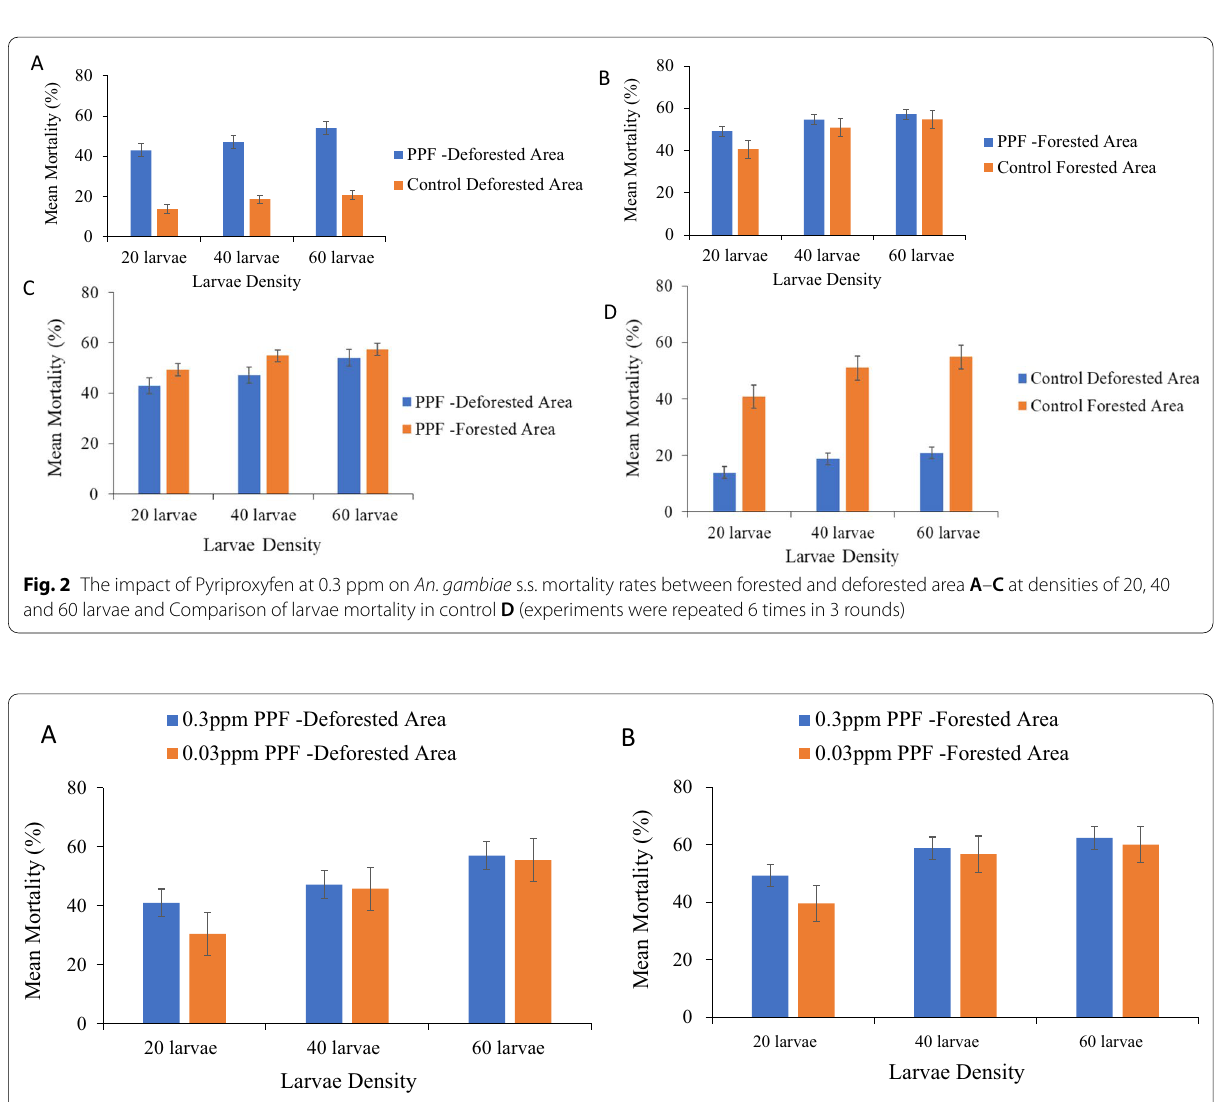
Fig. 3 Effect of changing PPF concentration from 0.03 to 0.3 ppm ( A and B ) on An. gambiae larvae mortality rates at 20, 40 and 60 larvae (Experiments repeated in 6 times and 3